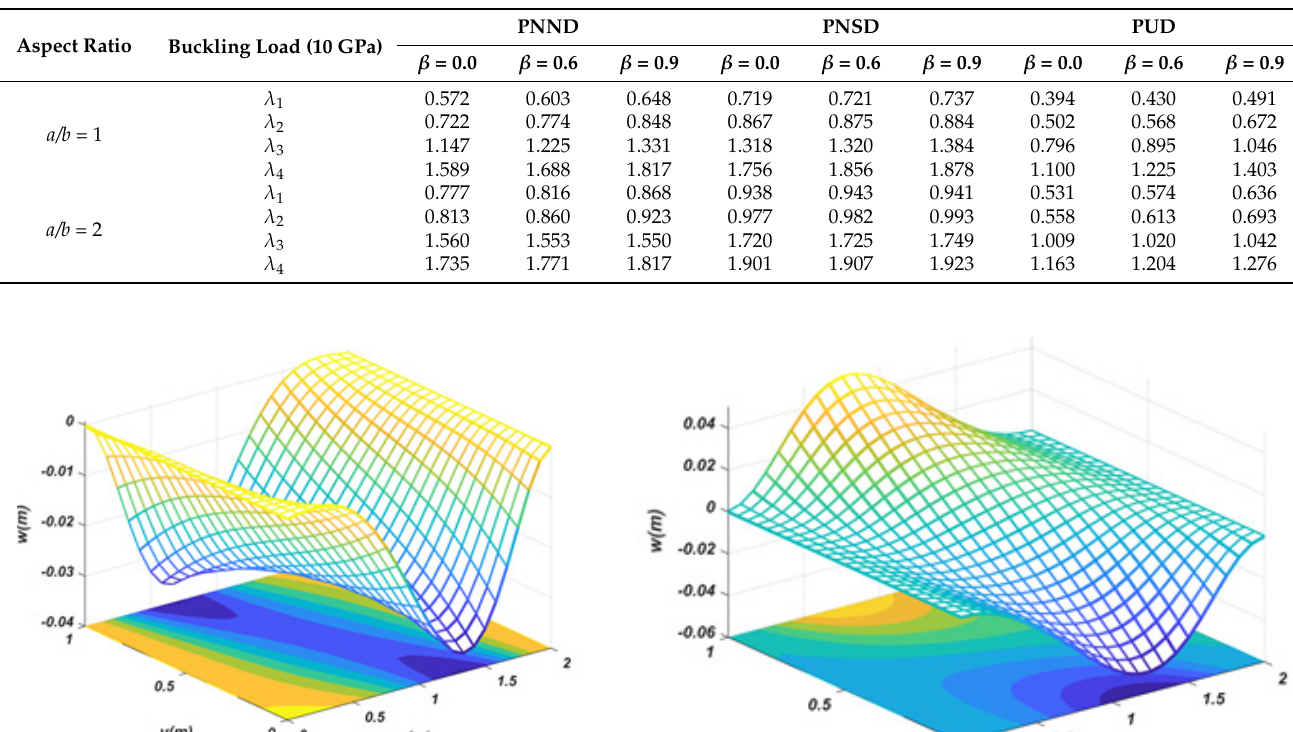
Table 11. First four uniaxial buckling loads ( x -direction) for a SSSS FG-saturated porous plate with different aspect ratios, a / b , porosity distributions and Skempton coefficients, β , while keeping e 0 = 0.6 fixed.